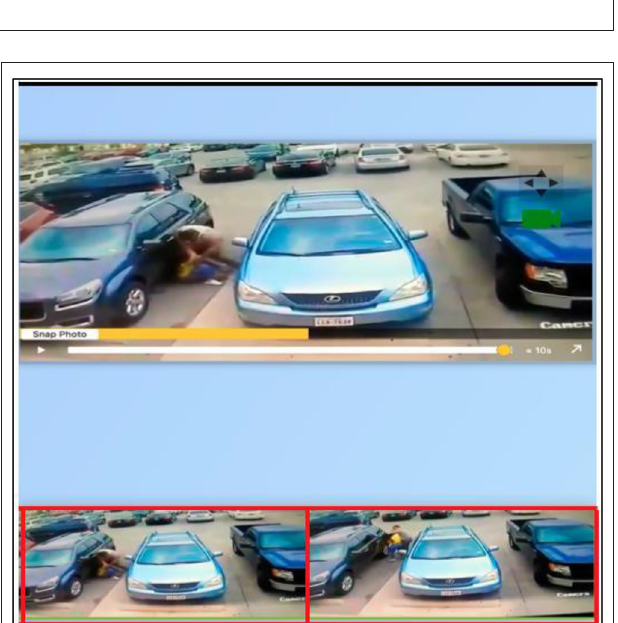
FIGURE 5 | Digital prototype media screen.